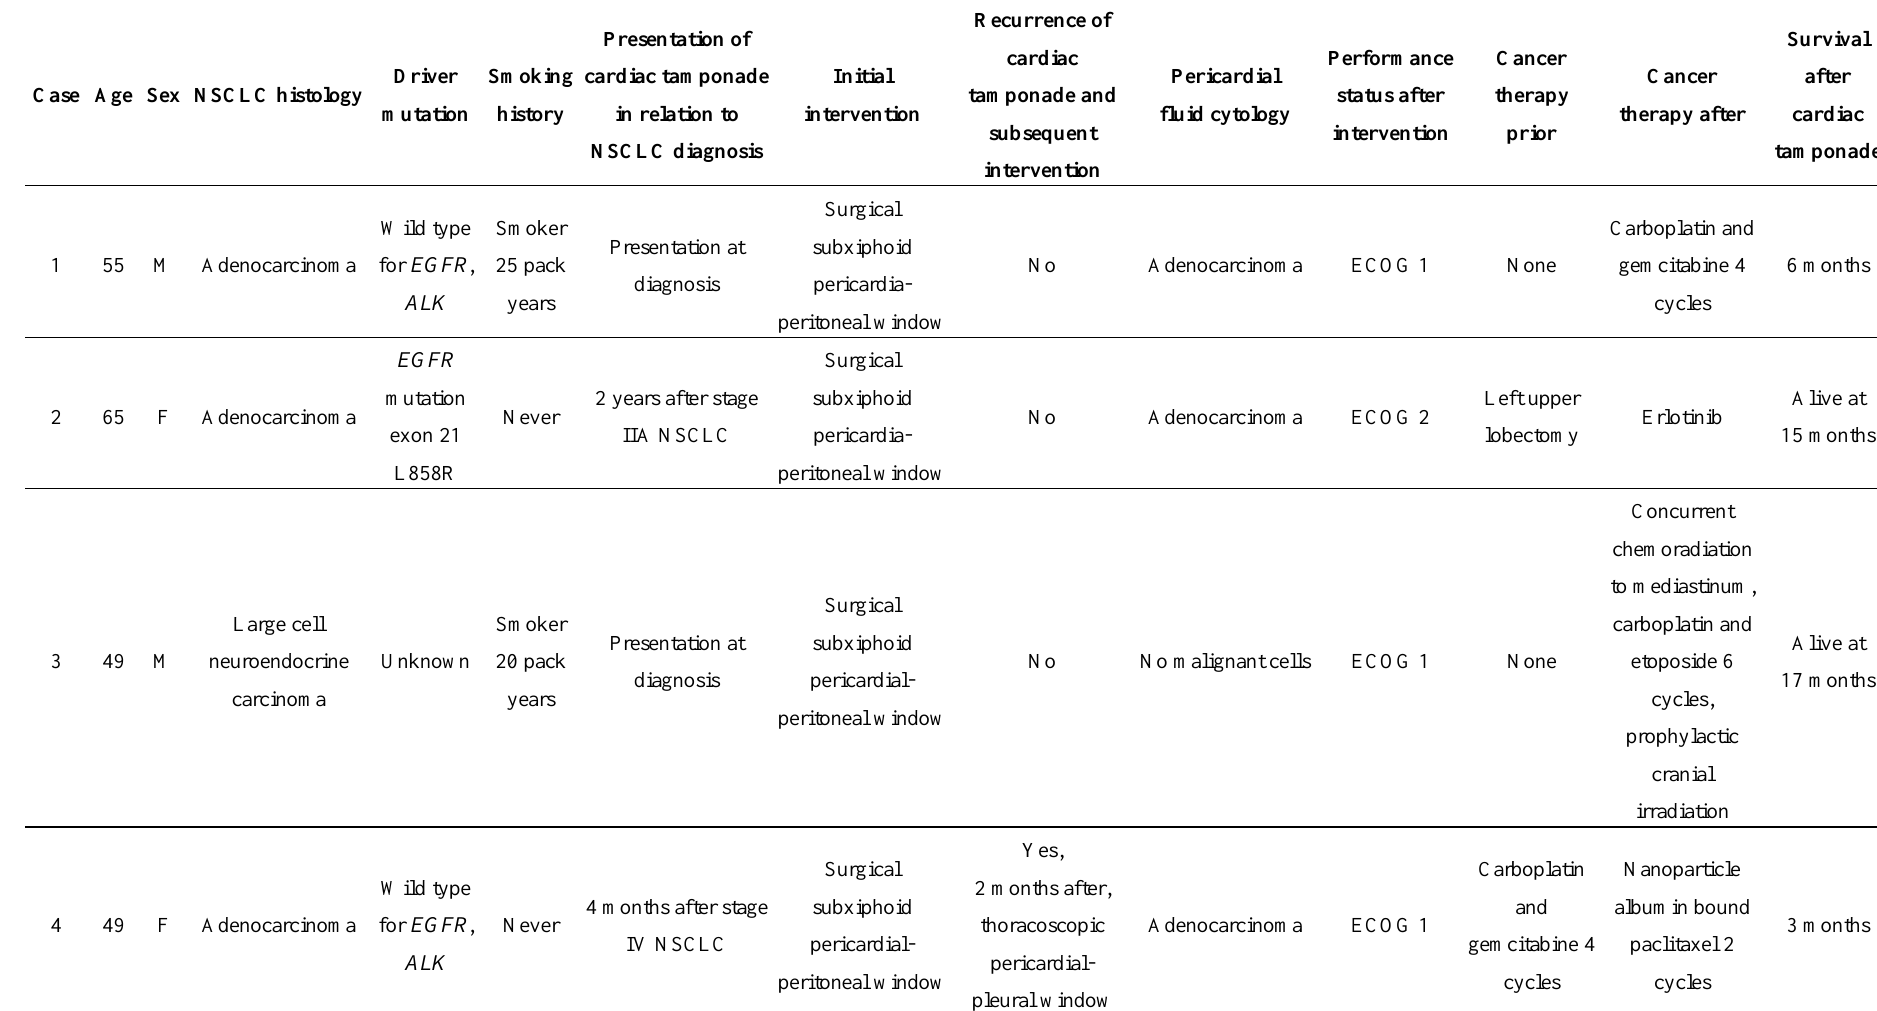
Table 1. Demographics, clinical characteristics and treatment outcomes of case series. Abbreviations: Age in years (Age); Male (M); Female (F); Eastern cooperative oncology group (ECOG); non-small cell lung cancer